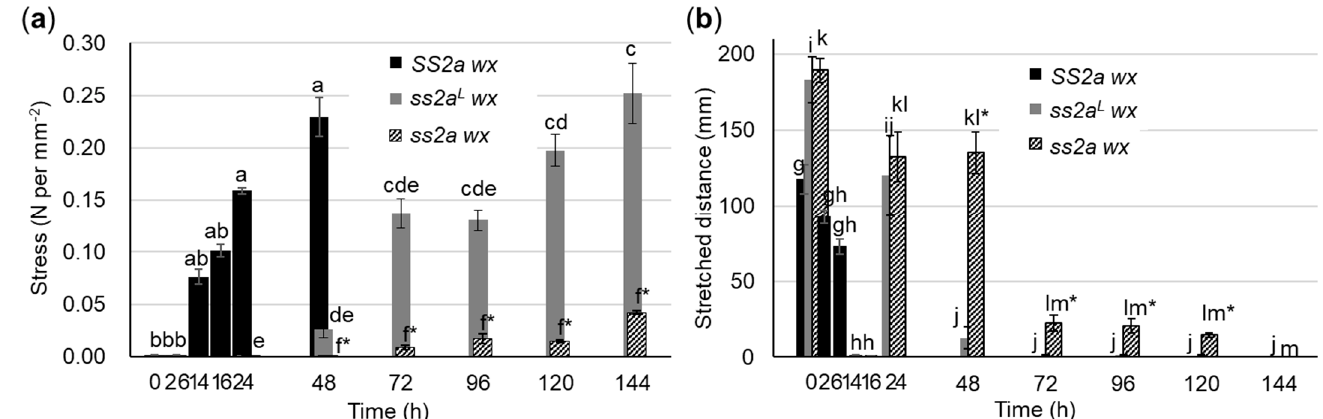
Figure 7. Viscoelasticity of rice cakes prepared from purified starch and stored at 4 °C. ( a , b ) Compression test ( a ) and stretching test ( b ) of rice lines performed using a tabletop universal tensile testing machine. Rice cakes of SS2a wx were stored at 4 °C for 0, 2, 6, 14, 16, 24, and 48 h, while those of ss2a L wx and ss2a wx were stored at 4 °C for 0, 24, 48, 72, 92, 120, and 144 h. Data represent the mean ± SE of three replicates. Different lowercase letters indicate significant differences among different storage time of individual line (Tukey–Kramer method, p < 0.05); SS2a wx (a, b), ss2a L wx (c, d, e) and ss2a wx (f) for compression tests, and SS2a wx (g, h), ss2a L wx (i, j) and ss2a wx (k, l, m) for stretching tests. Asterisks indicate significant differences between ss2a L wx and ss2a wx at the same storage time ( t -test, p < 0.05).